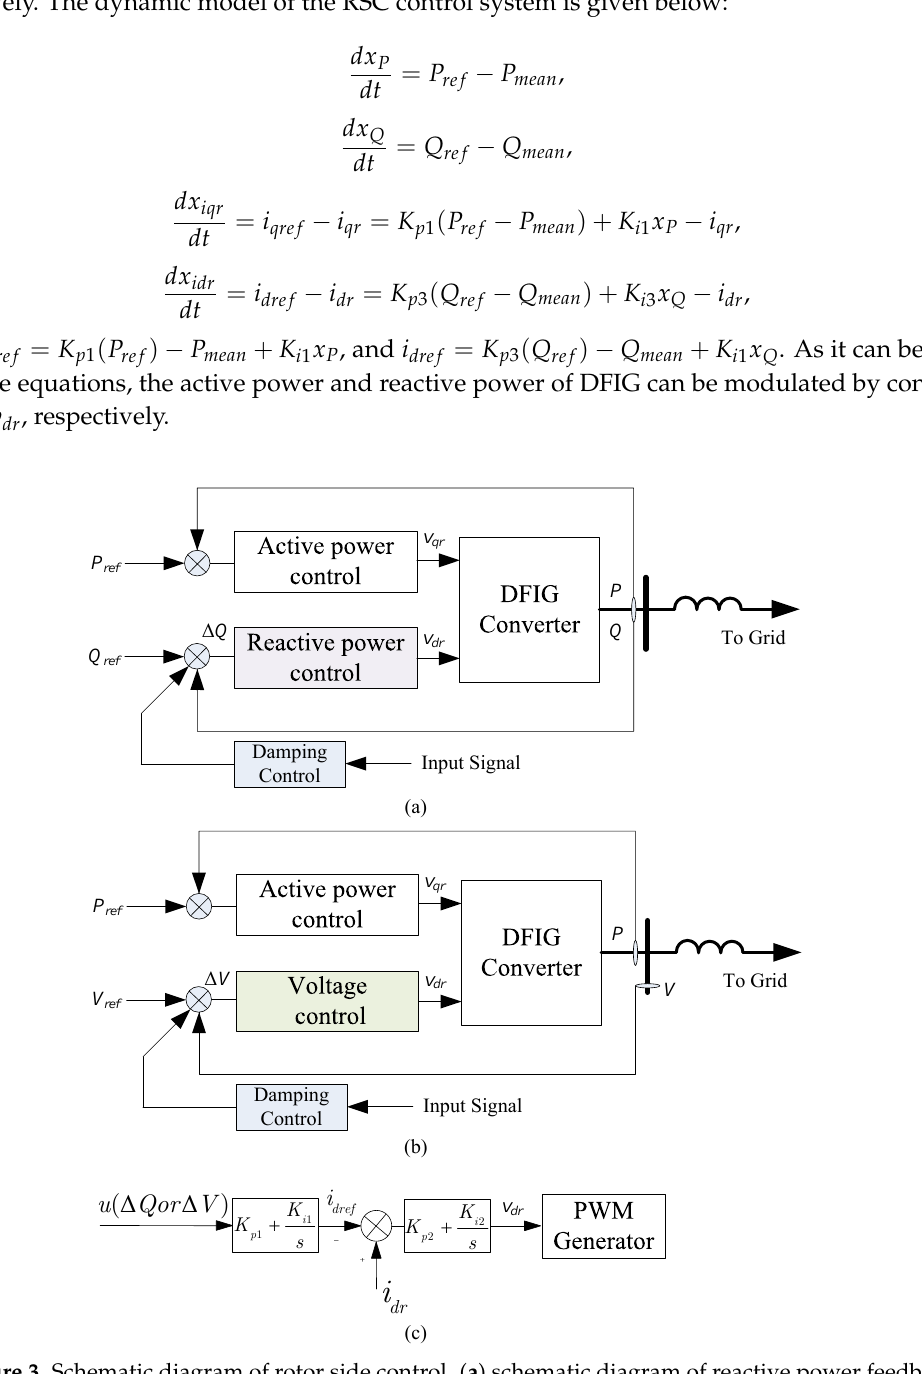
Figure 3. Schematic diagram of rotor side control. ( a ) schematic diagram of reactive power feedback control; ( b ) schematic diagram of voltage feedback control; ( c ) schematic diagram of inner PI